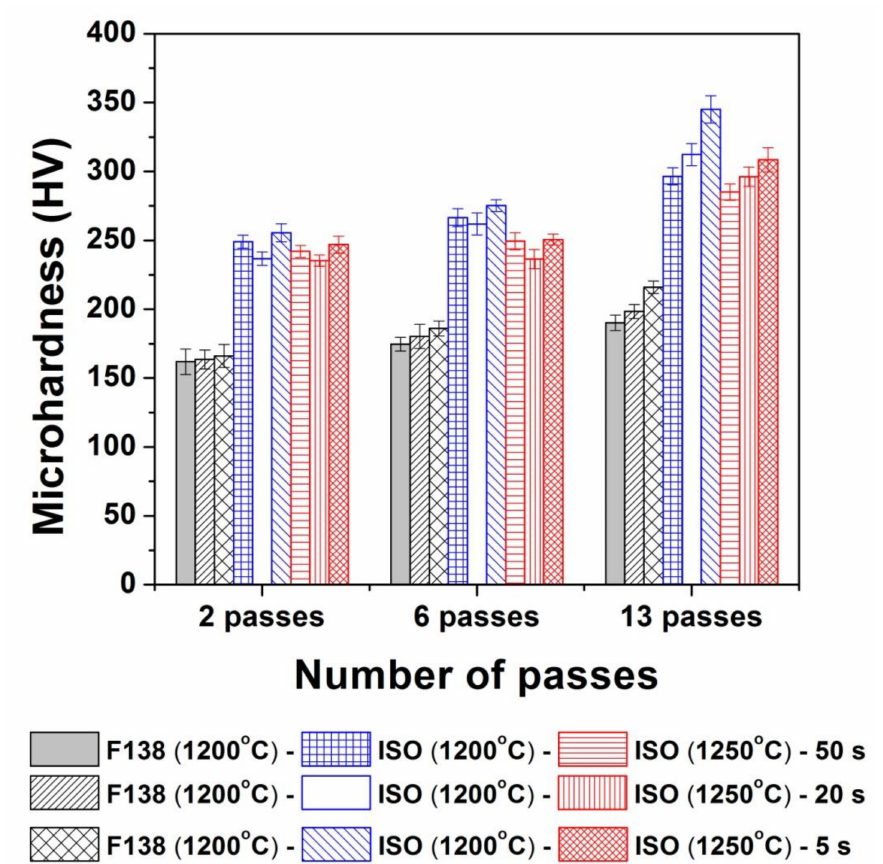
Figure 11. Microhardness dependence with the pass number and interpass time for the steels F138 and ISO 5832-9. Error bars represent the standard deviation obtained from microhardness